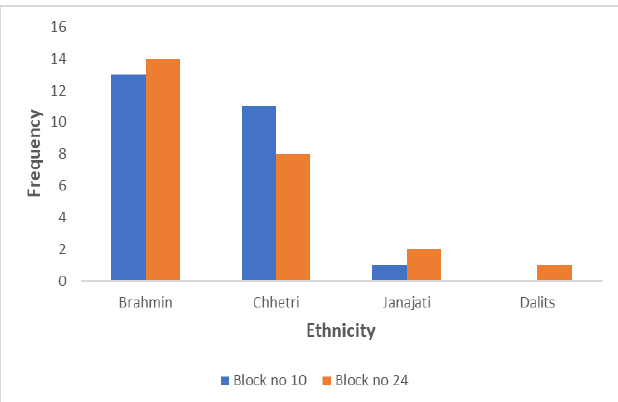
Figure 2: Ethnicity of Block 10 and 24 of Tikapur Municipality, Kailali